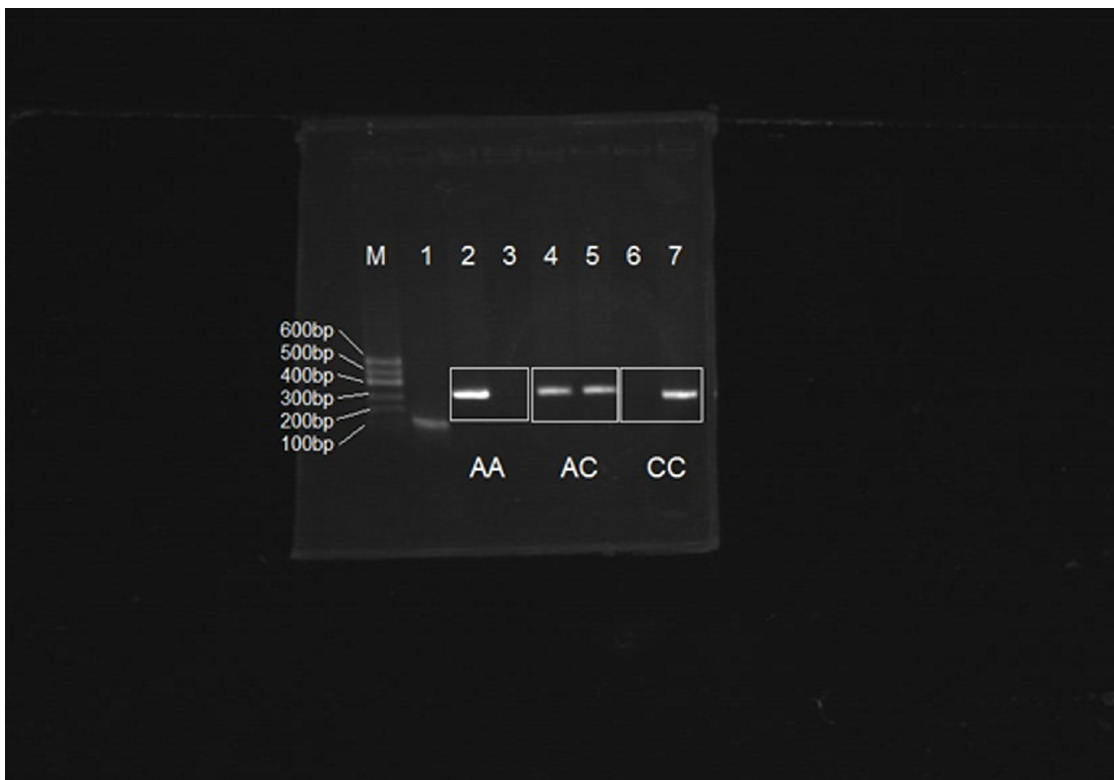
Figure 2. Foxp3-3279 C allele in Agarose gel electrophoresis. Lane 1 showed the b -Actin, Lane 2 and 4 showed the positive PCR products amplified by group A primer (F1 primer); Lane 6 showed the negative PCR products amplified by group A primer. Lane 5 and 7 showed the positive PCR products amplified by group C primer (F2 primer); Lane 3 showed the negative PCR products amplified by group C primers; Lane M:DNA marker. doi:10.1371/journal.pone.0059696.g002 PLOS ONE |